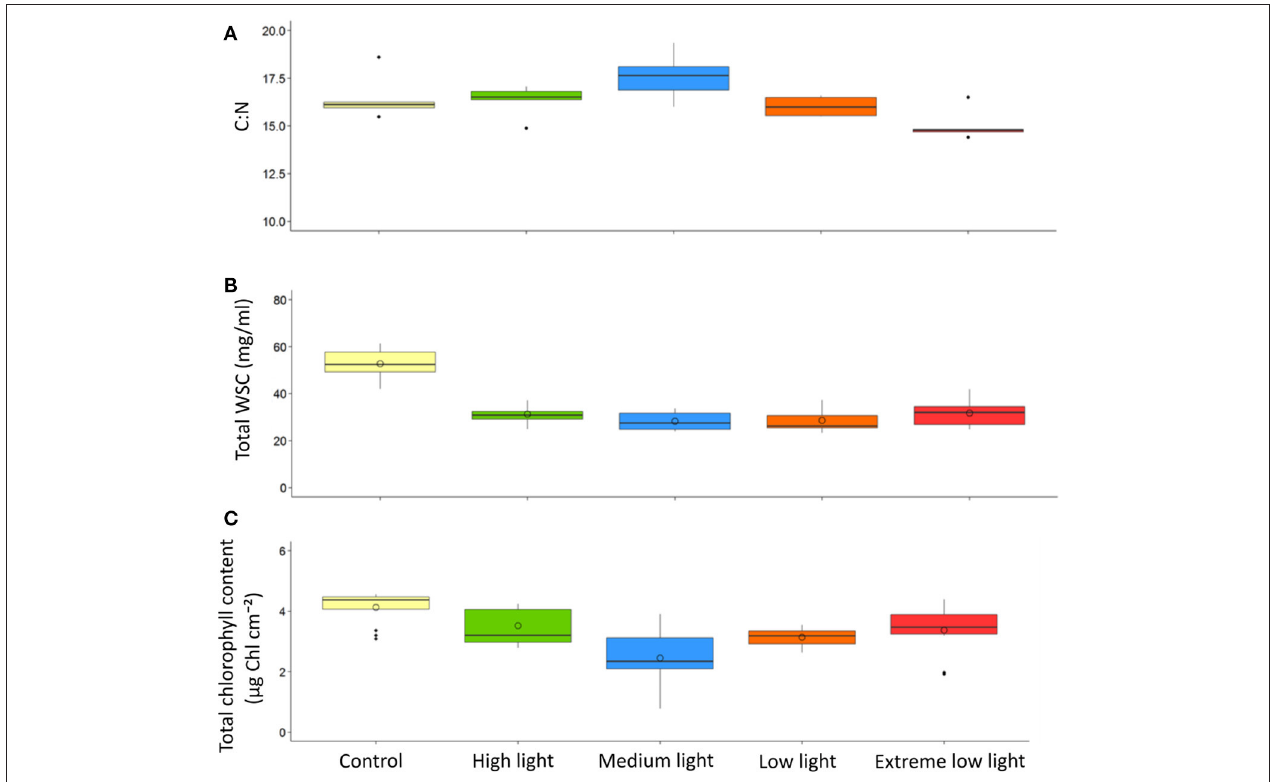
FIGURE 3 | Effect of light shading on physiological properties of Z. marina with time. Plants were kept in a flow through aquaria using natural filtered seawater under artificial light. Boxplots show results from control site plants compared with plants at the end of the experiment. (A) C:N (B) Total water soluble carbohydrates(WSC), (C) Total chlorophyll content. Central line is the median, o point is the mean, n = 5.